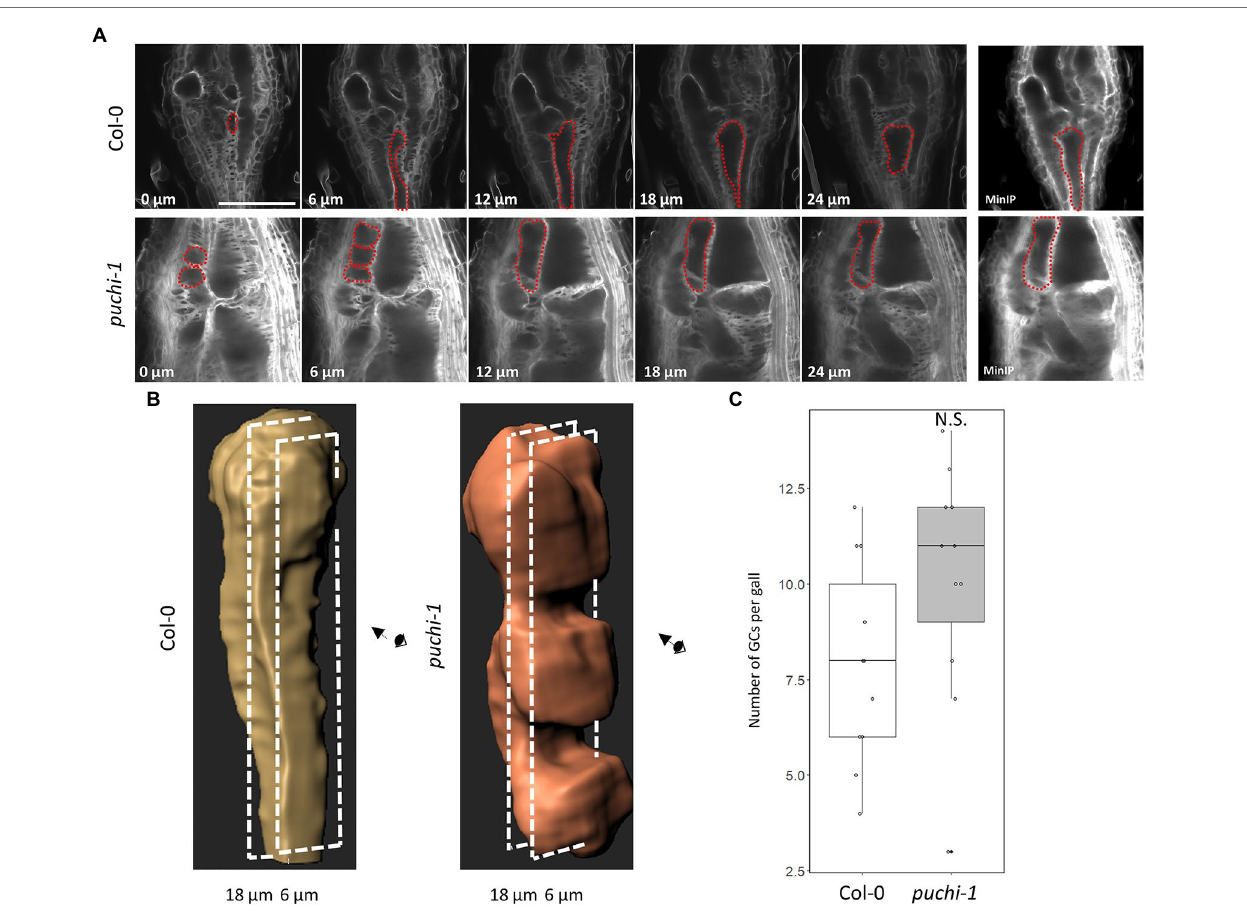
FIGURE 5 | Reconstruction of 3D structures of WT and puchi-1 GCs. (A) Confocal optical sections of WT and puchi-1 galls stained with Calcofluor White at 7 dpi, and red dashed lines outline the same GC in different sections and the minimum intensity projection (MinIP) of the WT and puchi-1 optical section Z-stacks.